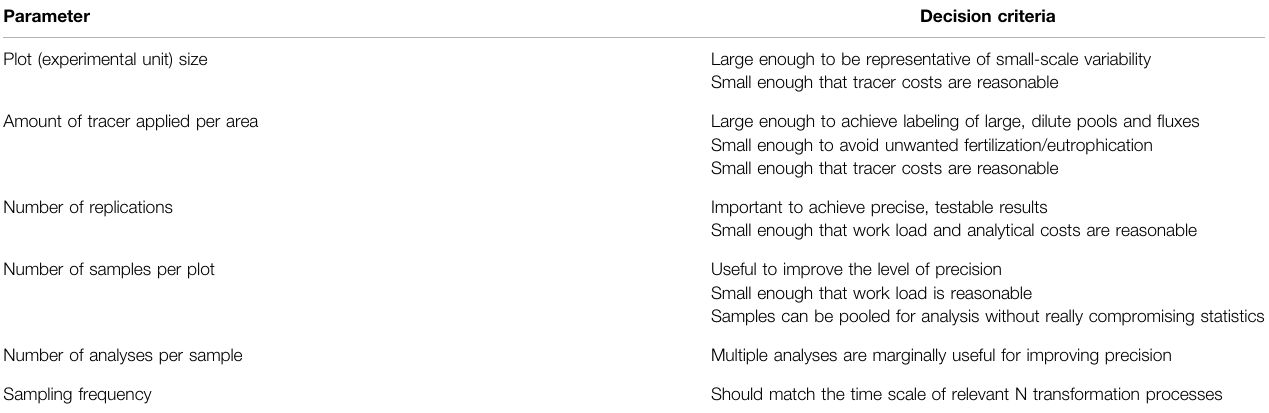
TABLE 1 | Decision scheme for whole ecosystem 15 N tracer studies. Parameter Decision criteria Plot (experimental unit) size